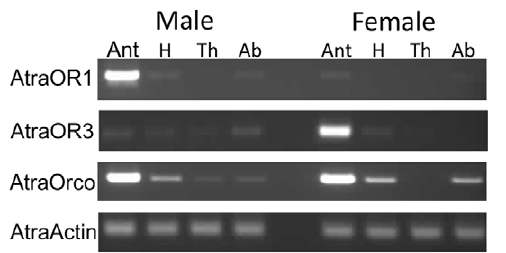
Figure 4. Expression profiles of navel orangeworm odorant receptors. The odorant receptor co-receptor, AtraOrco, was expressed equally in male and female antennae. AtraOR1 was highly expressed in male antennae, whereas AtraOR3 was enriched in female antennae.